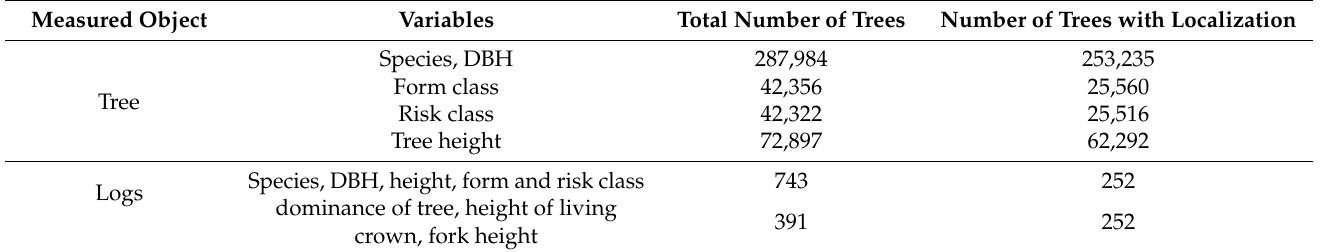
Table 2. Overview of number of observations for different variables for trees and logs measured.